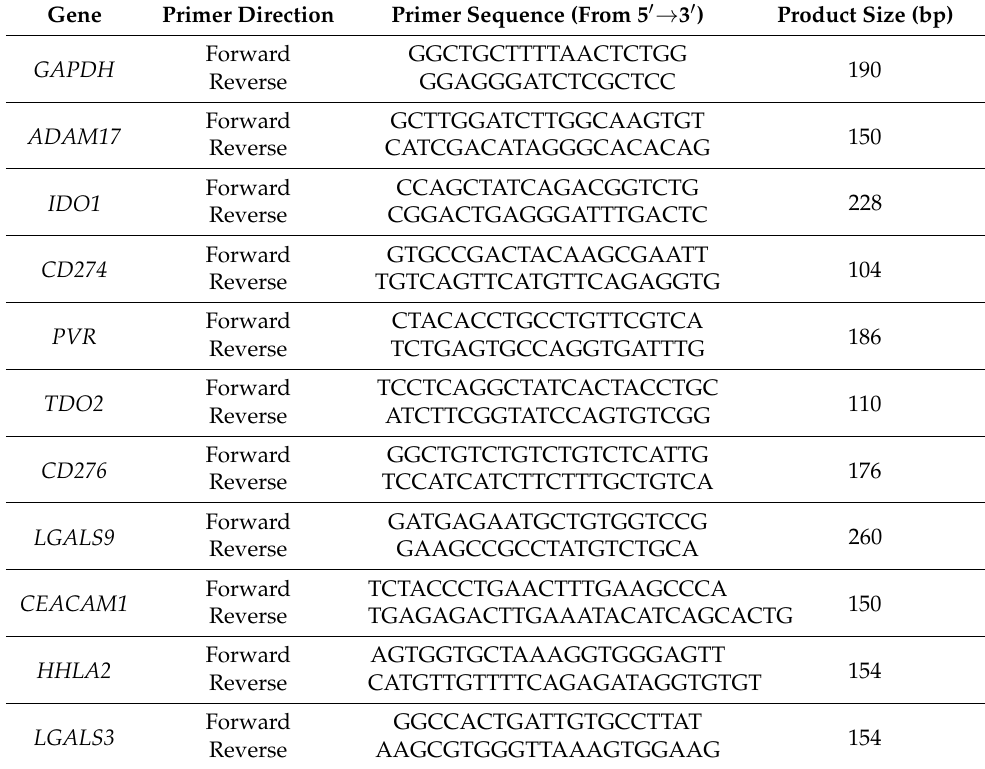
Table 8. Primer sequences for qRT-PCR and their amplicon size. Gene Primer Direction Primer Sequence (From 5 (cid:48) → 3 (cid:48)